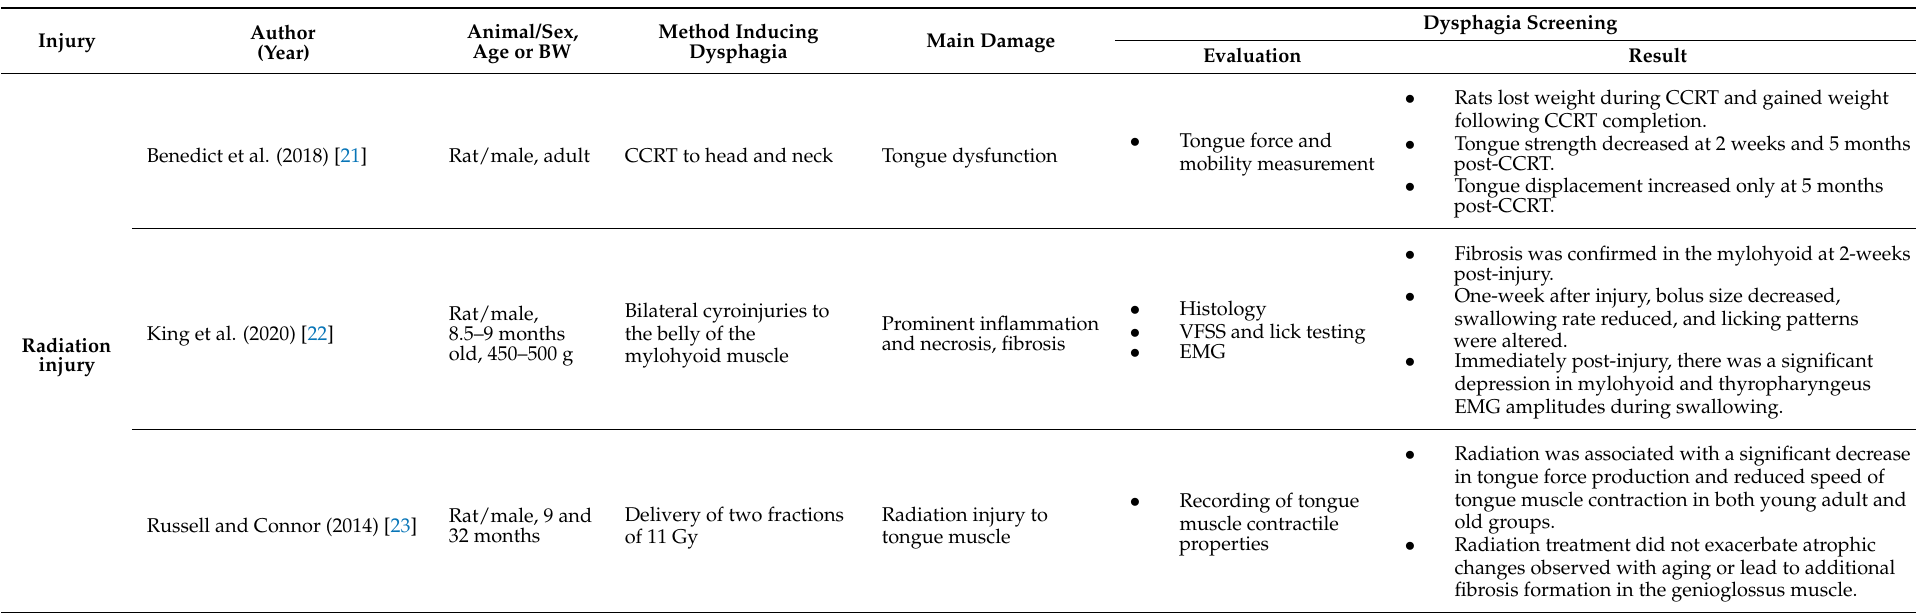
Table 3. Characterization of oropharyngeal dysphagia in rodent models of radiation injury.